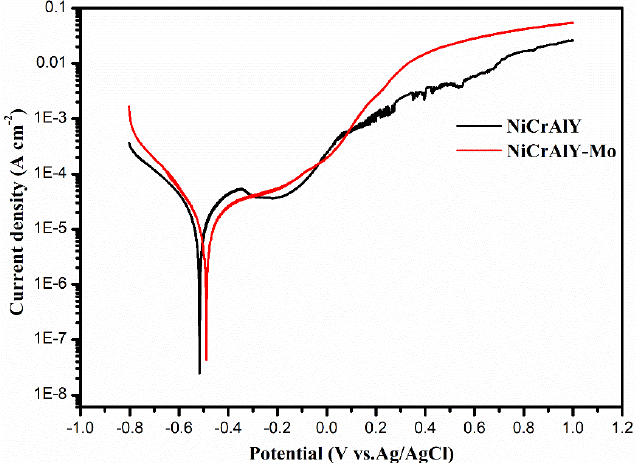
Figure 5. Potentiodynamic polarization curves of the NiCrAlY and NiCrAlY-Mo coatings’ sliding condition in artificial seawater. Table 4. Corrosion parameters of coatings from potentiodynamic polarization curves.